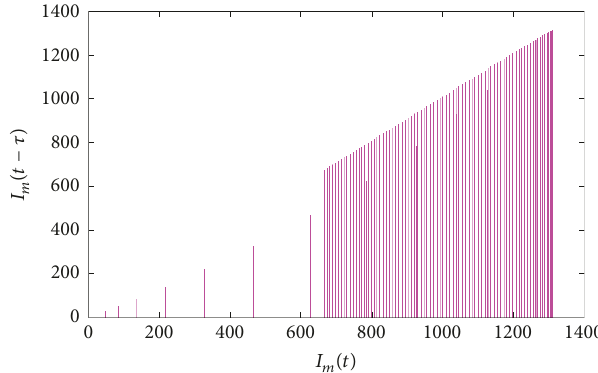
Figure 8: The approximate solutions 𝐼 𝑚 (𝑡 − 𝜏) with 𝜏 = 2 , 𝛼 = 0.98 using NSFDM.